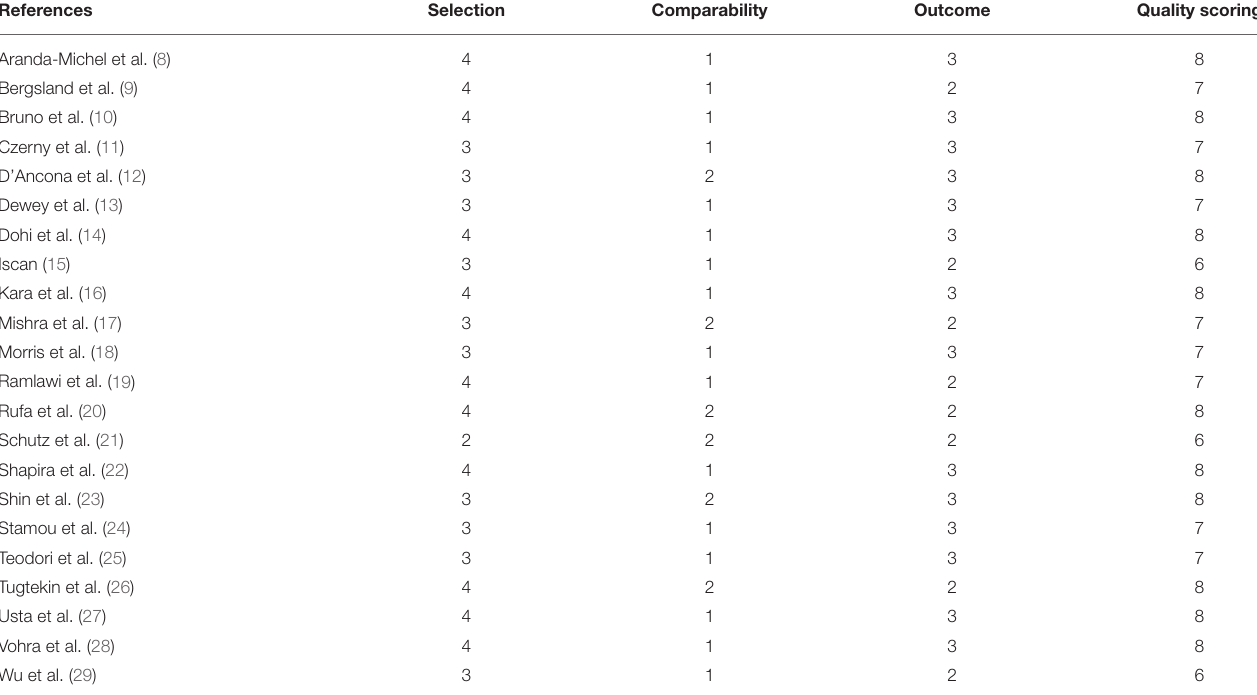
TABLE 1 | Quality assessment of included studies.